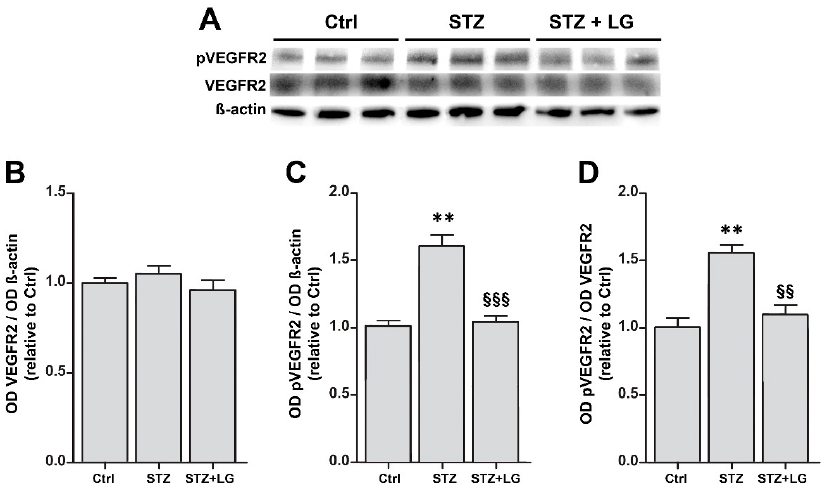
Figure 8. ( A ) Western blots showing immunoreactive bands of VEGF receptor 2 (VEGFR2), of phosphoVEGFR2 (pVEGFR2) and of ß-actin, used as an internal standard, i n control rat retinas and in retinas of STZ rats with or without LG treatment. ( B,C,D ) Graphs representing the ODs of the immunoreactive bands to quantify the protein expression of VEGFR2 ( B ), that of pVEGFR2 ( C ), and the ratio pVEGFR2/VEGFR2 as a measure of VEGFR2 activation ( D ). Each column represents mean ± SD. ** p < 0.01 vs. Ctrl; §§ p < 0.01 vs. STZ; §§§ p < 0.001 vs. STZ; n = 3 for all measures. Power value: 0.99.